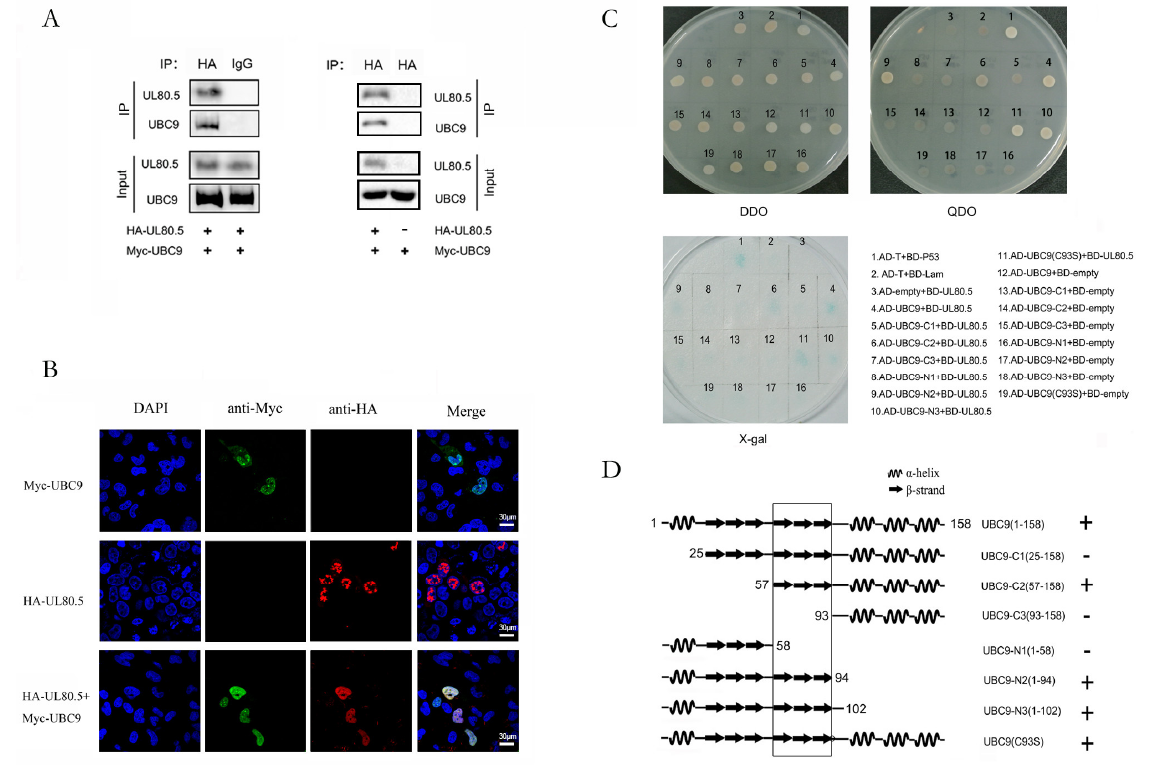
Figure 1. UL80.5 interacts and co-localizes with UBC9. ( A ) HEK293T cells were transfected with Myc-UBC9 with or without HA-UL80.5. Cell lysates were subjected to Co-IP with HA antibody or IgG followed by immunoblot analysis. Data are representative of three independent experiments. ( B ) U251 cells were transfected with HA-UL80.5 alone, Myc-UBC9 alone, or HA-UL80.5 with Myc- UBC9. Subcellular localizations of HA-UL80.5 (red), Myc-UBC9 (green), and the nucleus marker DAPI (blue) were examined by confocal microscopy. The scale bar is 30 µ m. Data are representative of three independent experiments. ( C ) Yeast strain AH109 cells were transformed with the combination of BD and AD plasmid, as indicated. Transformed yeast cells were first grown on SD-minus Trp/Leu plates for three days. The colony of yeast was then streaked on SD-minus Trp/Leu/Ade/His plates (QDO) for two days and also subjected to a β-galactosidase activity test(X-gal). BD-p53 and AD-T were used as a positive control and BD-lam and AD-T were used as a negative control. Data are representative of two independent experiments. ( D ) The schematic view and structural features of UBC9 deletion mutants and their interaction with UL80.5 as detected by yeast two-hybrid. +, positive interaction; −, no interaction. The interaction domain was indicated by a box.